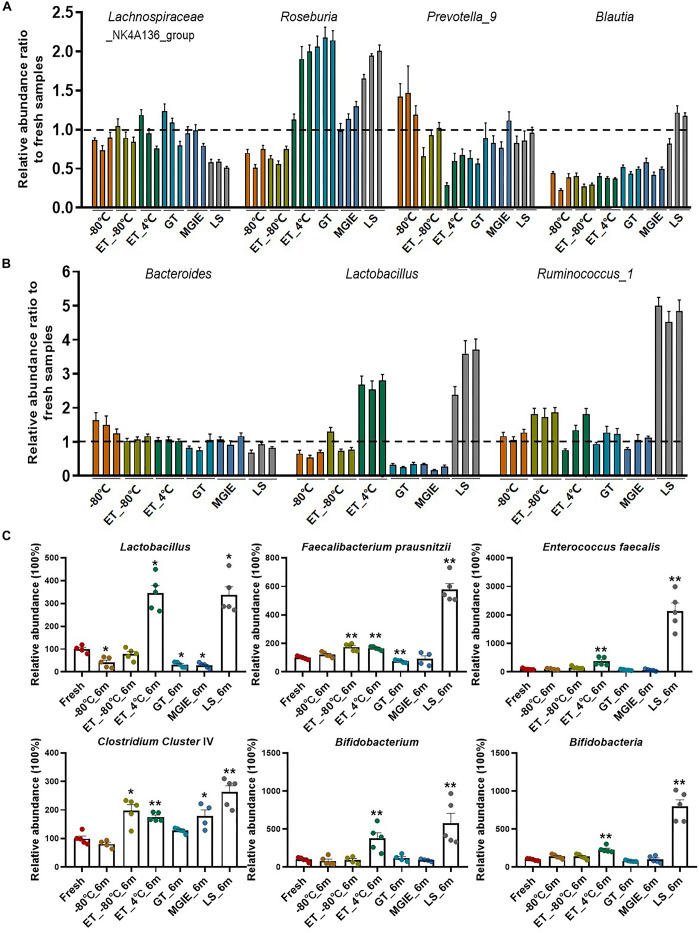
Relative abundance ratio of bacteria involved in SCFA-producing and bile acid metabolism on genus levels. (A,B) Relative abundance ratio (storage samples/fresh samples) of bacteria involved in SCFA-producing and bile acid metabolism on genus levels, and three columns with the same color represent 1 week, 2 weeks, and 6 months from left to right, respectively. (C) Qualification of the functional bacteria relative to fresh samples using QPCR. n = 5 per group. *p < 0.05, **p < 0.01, compared with fresh group.